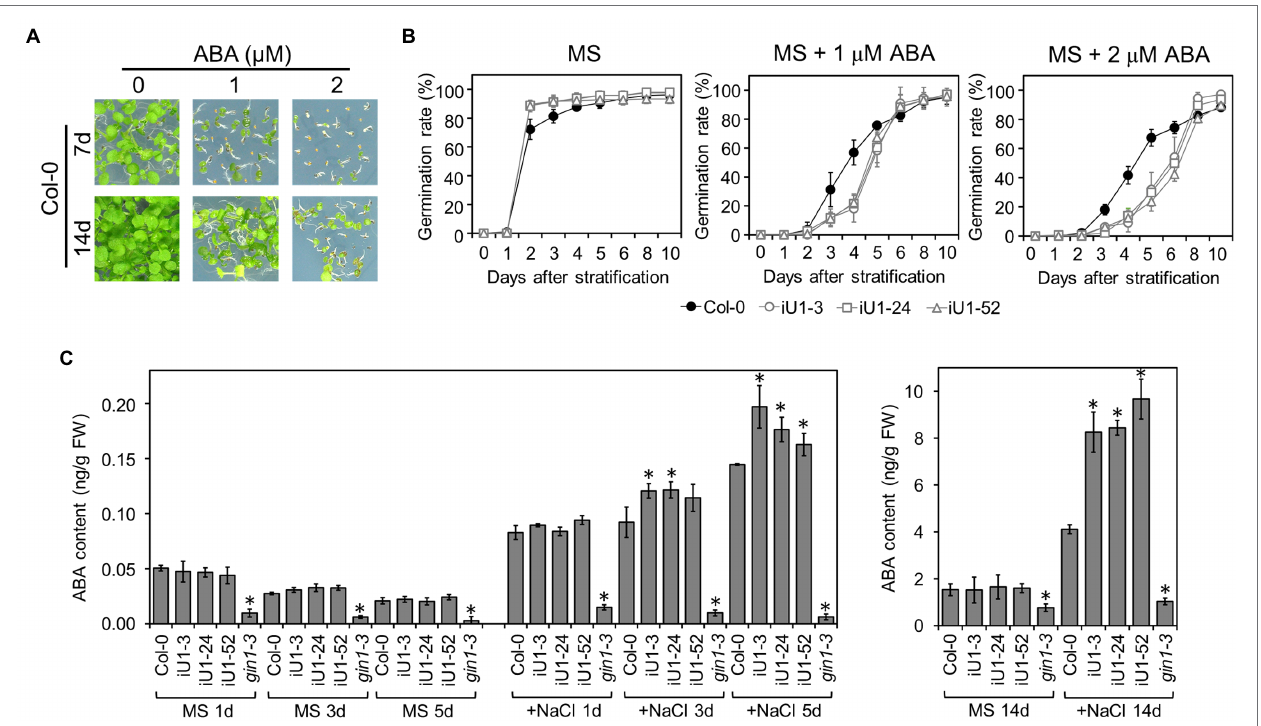
FIGURE 6 | The iU1 plants increased the ABA contents under salt treatments. (A) Inhibition of seed germination by exogenous ABA. (B) Seed germination rate. Seeds were sown on agar plates supplemented with or without ABA. Data are presented as the means ± SD of at least 12 biological replicates. Each replicate contained ~40 seeds. (C) ABA contents of germinating seeds. Seeds germinated on MS or 200 mM NaCl medium for 1, 3, 5, or 14 days were harvested, and ABA was extracted and analyzed by LC/MS. The ABA-deficient mutant gin1-3 (also known as aba2 ) was used as an internal control. Data represent the means ± SD of three or four biological replicates. * p < 0.05, Student’s t